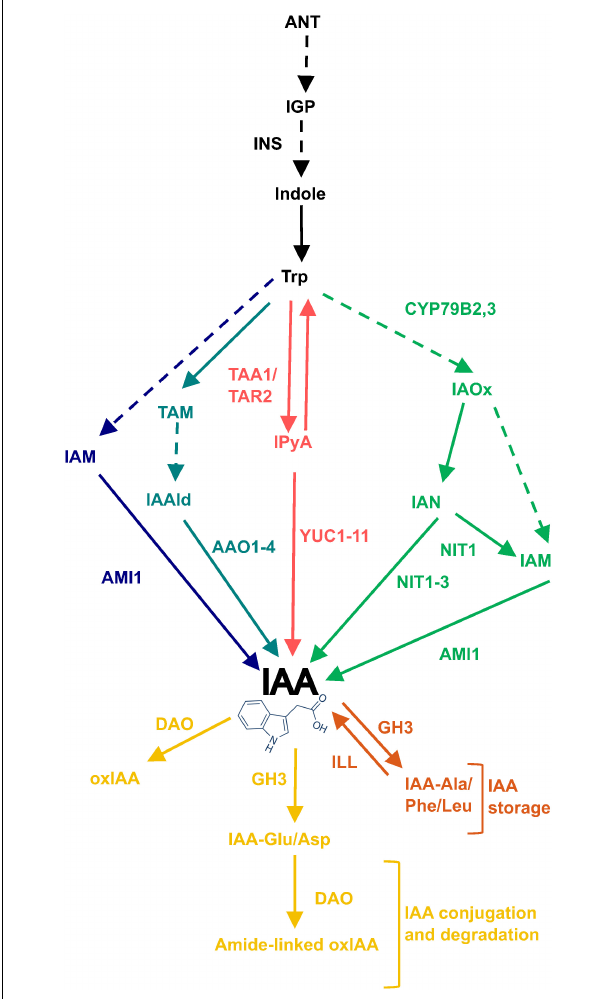
FIGURE 3 | Routes of tryptophan-dependent (TD) IAA biosynthesis and IAA oxidation and conjugation. The TD pathway of IAA biosynthesis has four proposed routes named for their key intermediates: IAM, TAM, IPyA, and IAOx shown in dark blue, light blue, red and green, respectively. Excess free IAA is removed either by direct oxidation or irreversible conjugation to Glu or Asp amino acids which tag it for oxidation, shown in yellow. Alternatively, excess IAA can be conjugated to Ala, Phe or Leu amino acids which tag it for storage, shown in orange. Solid arrows refer to reactions with identified enzymes and dashed arrows refer to unidentified/unconfirmed reactions. Enzymes involved are written next to the relevant arrow. ANT , anthranilate; IGP , indole-3-glycerol phosphate; INS , INDOLE SYNTHASE; IAOx , indole-3-acetaldoxime; CYP79B2,3 , CYTOCHROME P450 FAMILY 79B2,3; IAN , indole-3-acetonitrile; IAM , indole-3-acetamide; NIT1-3 , NITRILASE 1-3; AMI1 , AMIDASE 1; TAA1 , TRYPTOPHAN AMINOTRANSFERASE OF ARABIDOPSIS 1; TAR2 , TRYPTOPHAN AMINOTRANSFERASE RELATED 2; IPyA , indole-3-pyruvic acid; YUC1-11 , YUCCA 1-11; TAM , tryptamine; IAAld , indole-3-acetaldehyde; AAO1-4 , ARABIDOPSIS ALDEHYDE OXIDASE 1-4; IAM , indole-3-acetamide; oxIAA , 2-oxoindole-3-acetic acid; DAO , DIOXYGENASE FOR AUXIN